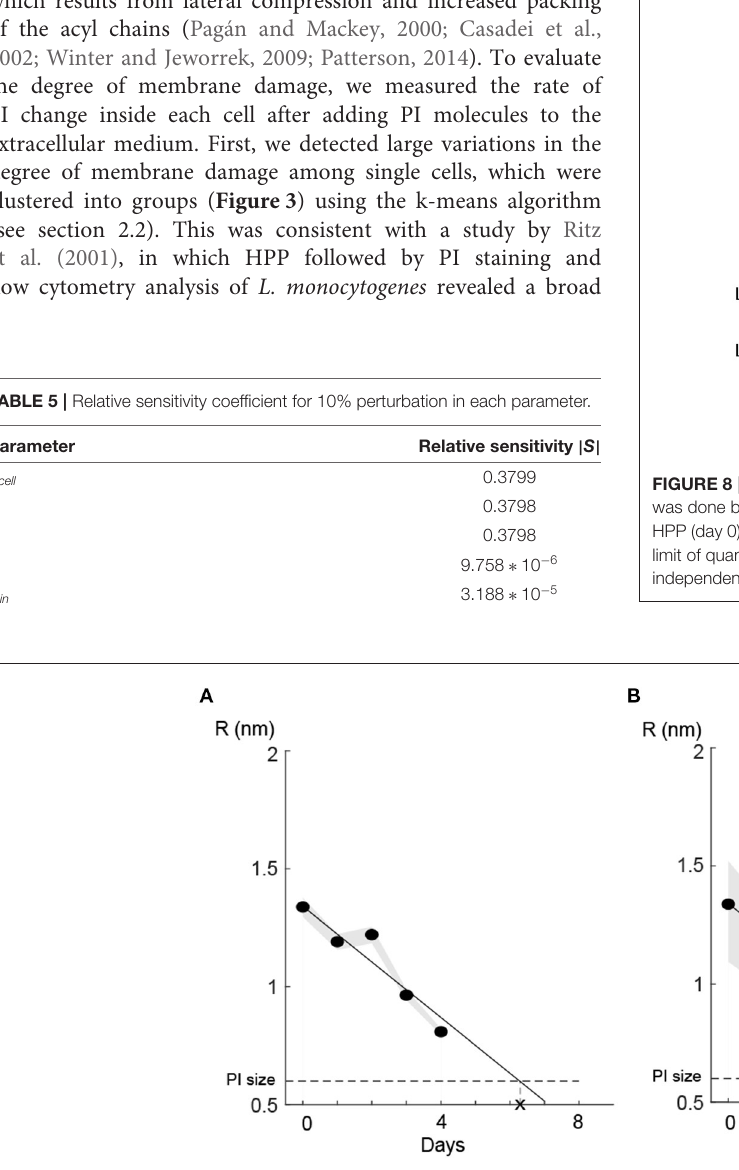
FIGURE 7 | Parametric uncertainty of the linear prediction for the cell volume ( Table 5 ) diminished with pore size. (A) 10% perturbation and (B) 50% perturbation in p = V cell = 0.7 ∗ 10 − 18 ( m 3 ). Shaded bounds show the deviation of the predicted R values from its nominal values (black solid line) due to parameter ( V cell ) uncertainty. For both perturbations of 10 and 50% of the nominal parameter value, the uncertainty region diminished as pores were resealed.